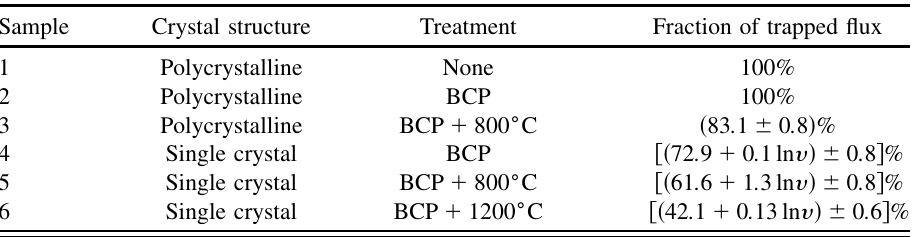
TABLE II. Flux trapping behavior of all measured samples. Only single crystal samples showed a dependence on the cooling rate (cid:3) (in mK/s). All measurements were done for 1 < (cid:3) < 80 mK = s .